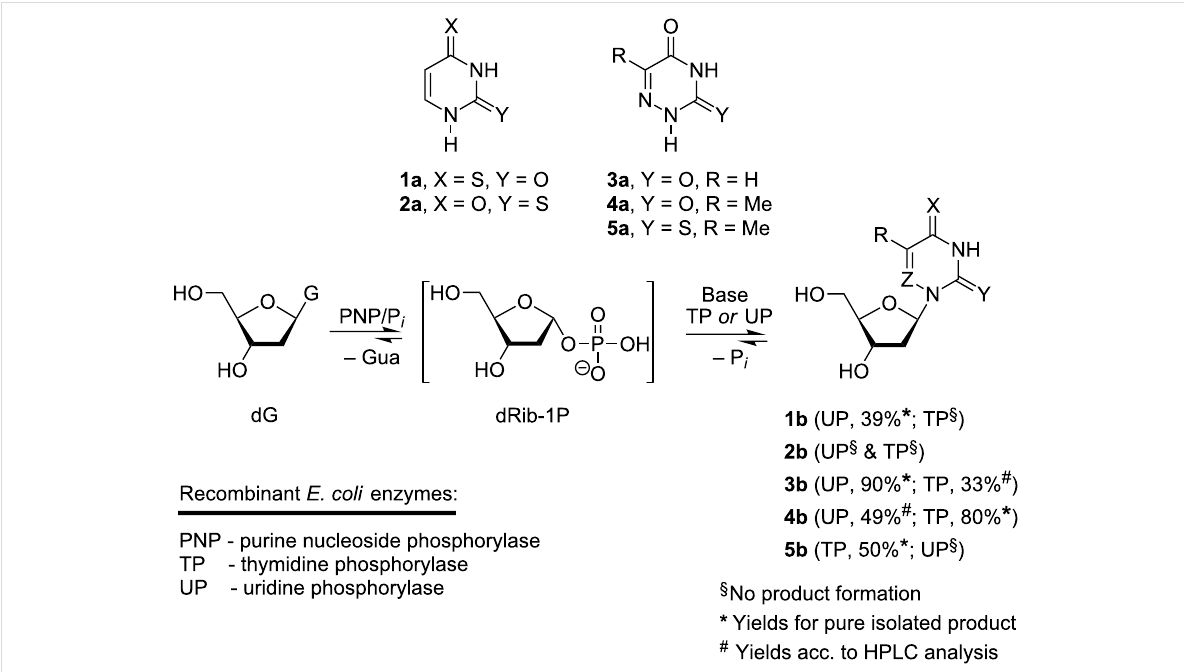
Scheme 1: Enzymatic synthesis of 2-deoxy- β -D-ribofuranosides 1b – 5b of the heterocyclic bases 1a – 5a . Regents and conditions: dG/base ratio: 1.5:1.0 (mol), 10 mM K,Na-phosphate buffer; 40 °C, 48–72 h; HPLC analysis of the reaction mixtures see Experimental section and Supporting Infor- mation File